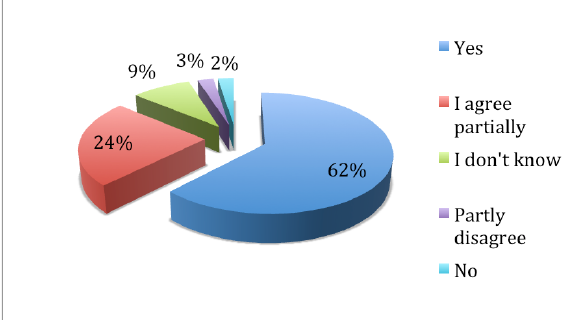
Figure 2. Do you consider SC activities relevant and/or useful for the development of your